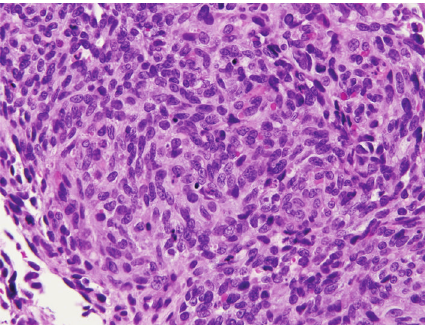
Figure 3: H & E stain of the liver biopsy—angiosarcoma with hyperchromatic spindle